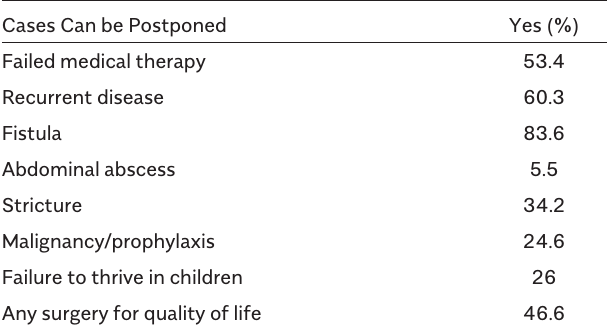
Table 5. Surgical Cases Can Be Postponed due to the COVID-19 Pandemic